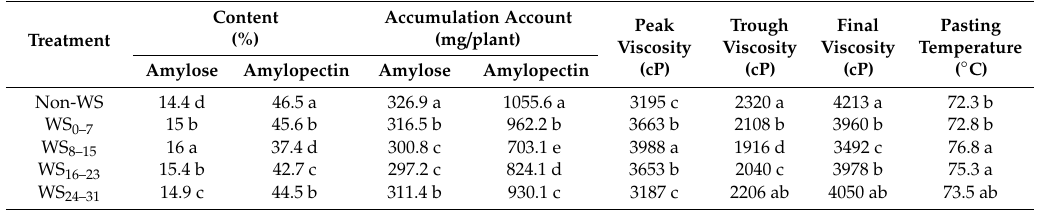
Table1. E ff ectofcombinedwaterloggingandshadingstressduringpost-anthesisonstarchaccumulation and paste traits of